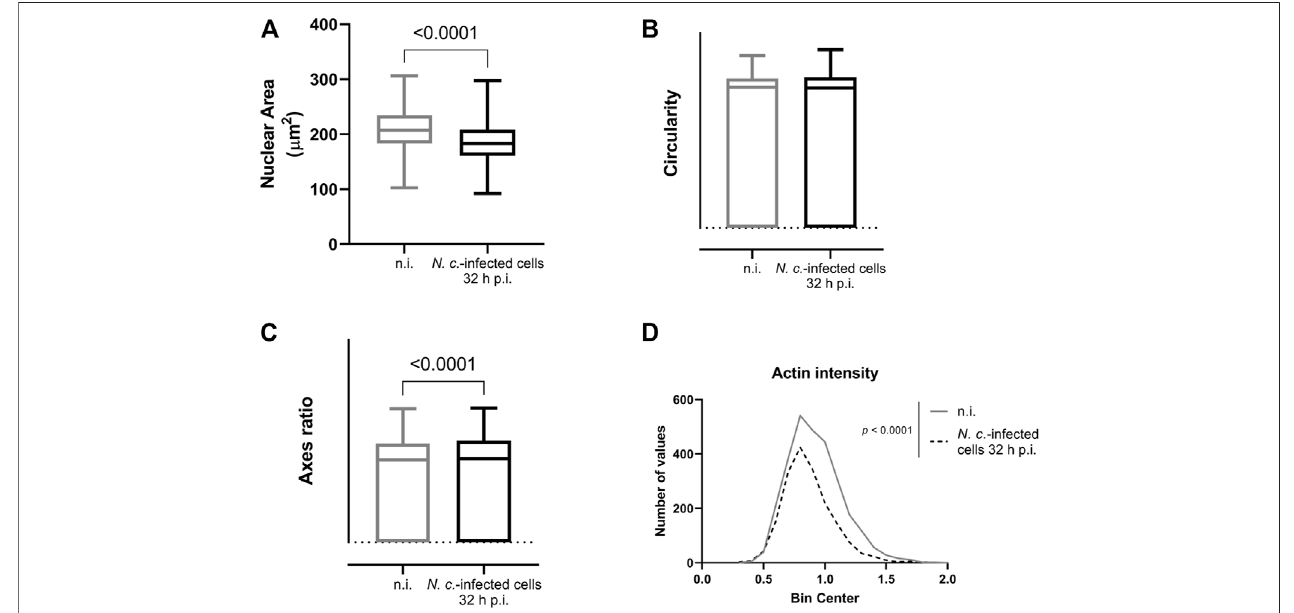
FIGURE5| Effectsof N.caninum infectiononclassicalnuclearparameters.Non-infectedand N.caninum- infectedhostendothelialcells(BUVEC)werestainedwith DAPI,andrandompicturesweretakenat 20Xformeasuringthehostcellnucleararea (A) ,circularity (B) ,nuclearaxisratio (C) ,andtheactinintensity (D) .Bars represent the median ±SD of three biological